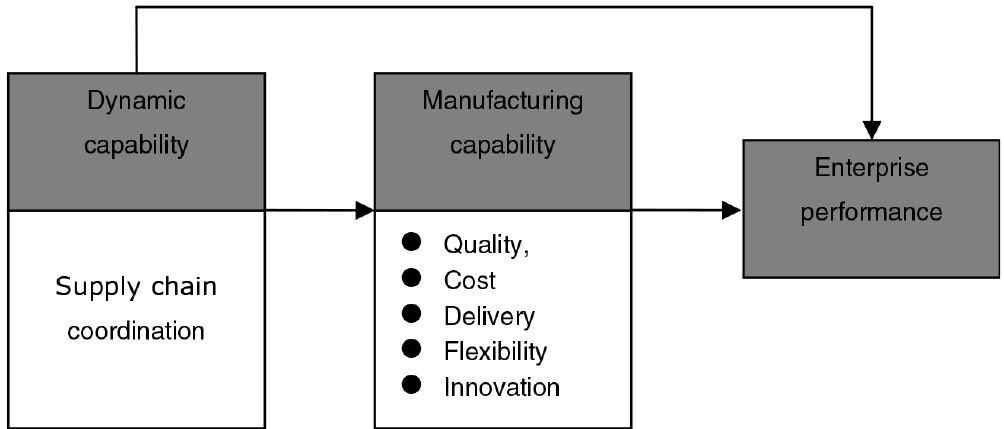
Figure 2. Schematic diagram of supply chain coordination causal